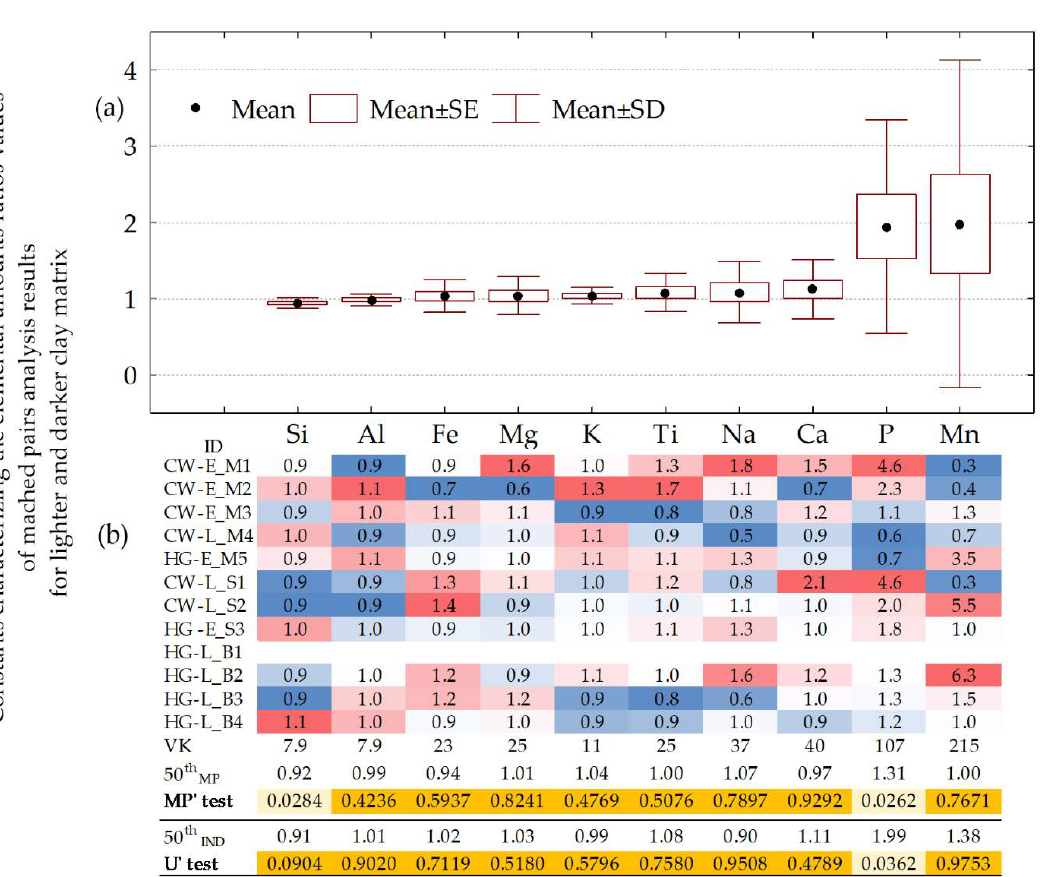
Figure 4. Elemental ratios of matched pairs of SEM-EDS analysis results for lighter and darker